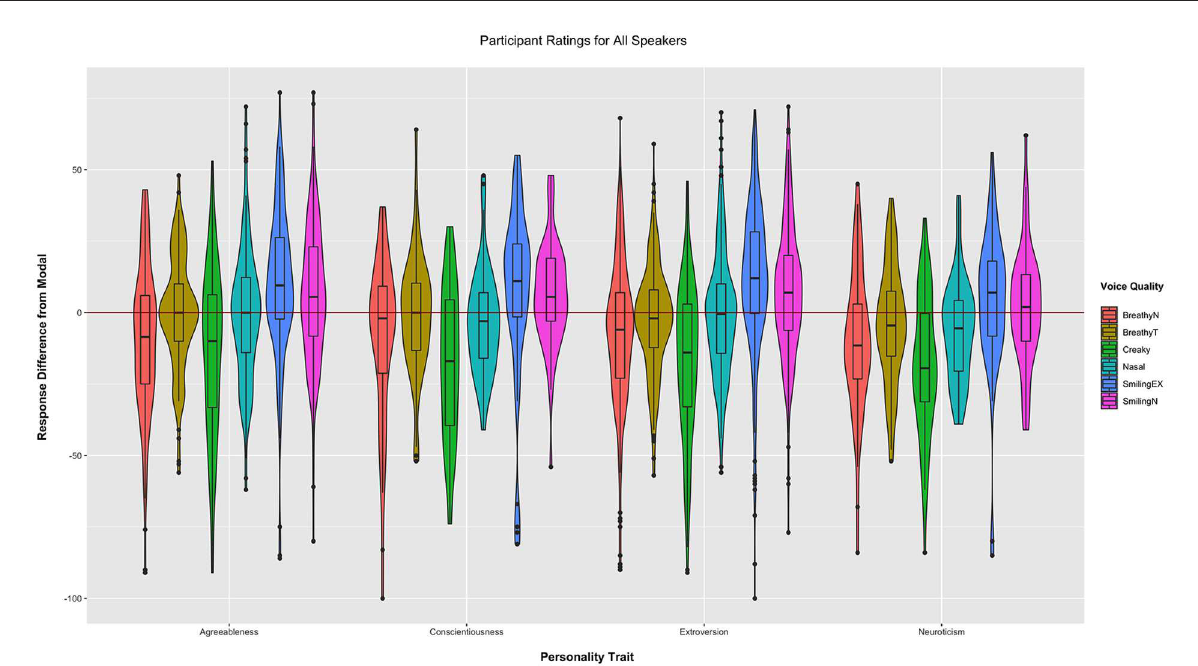
FIGURE4 Violin plot and overlaid boxplots of the point-wise difference ratings for all listeners aggregated over all 6 speakers’ productions. The y-axis displays the percentage difference as compared to each baseline (modal voice), i.e., the difference between each vocal quality rating and the corresponding modal voice quality (see text for further explanation). Positive rating difference percentages (compared to modal voice ratings) are above the 0% line; negative rating percentages are below this line. See Figure 3 for a description of axes and colors.